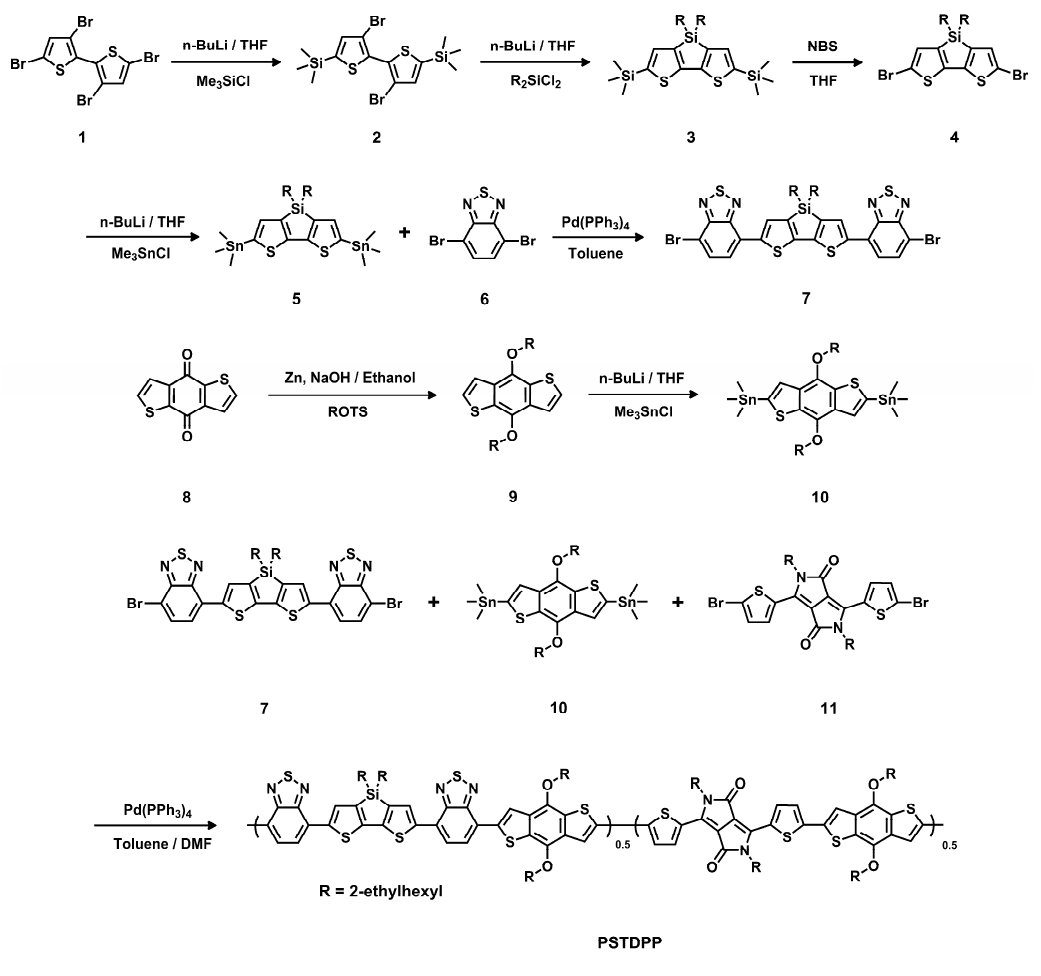
Scheme 1. Synthesis route of the